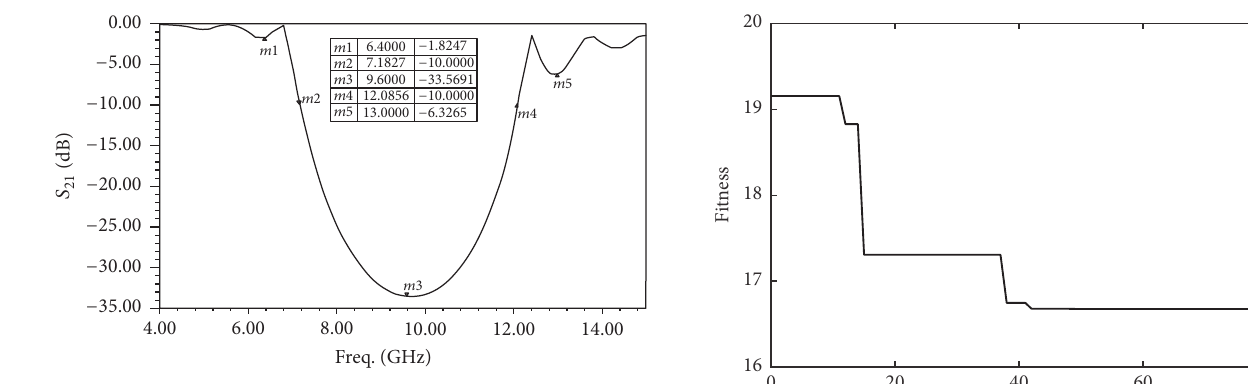
Figure 5: Simulated 𝑆 21 parameter of tapered dual-plane EBG.